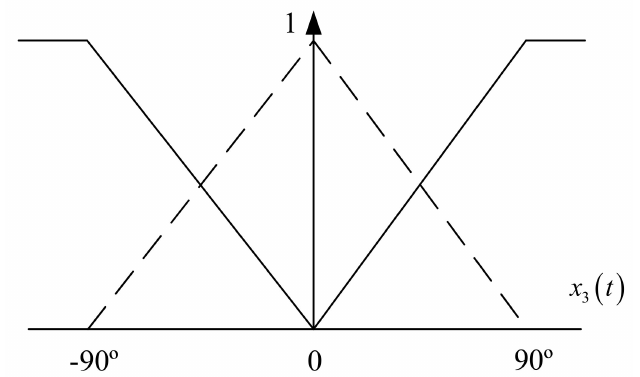
Figure 1. Membership